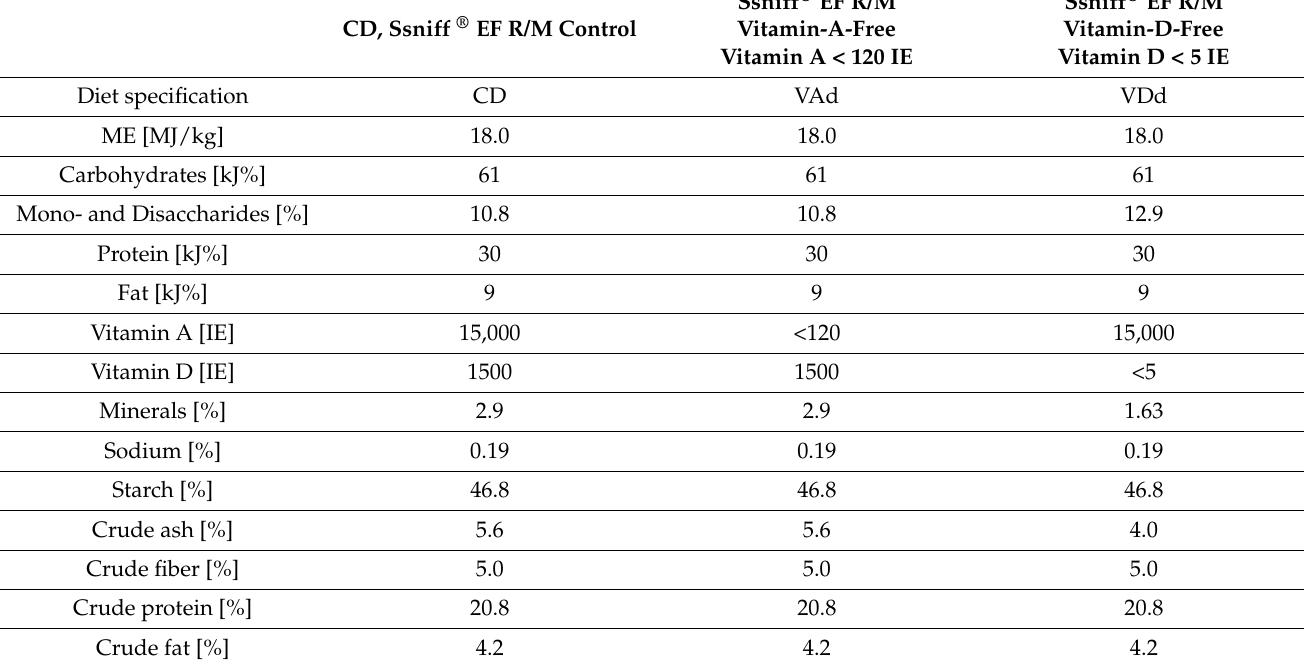
Table 1. Nutrient formulation of experimental diets fed to female C57BL/6J mice for 12 weeks (n = 12 per